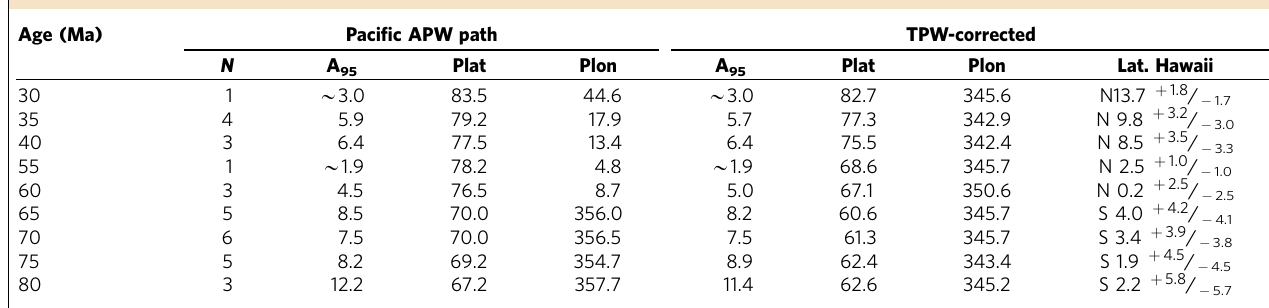
APW, apparent polar wander; TPW, true polar wander. ThePacific APWpath (Fig.8) was calculated from magneticanomaly skewness and palaeomagnetic modellingof seamounts 58–66 . We excludedall data fromthe Hawaiian-Emperor Seamounts because of possible non-dipole field contributions as discussed in the text. The APWpath is a running mean path (10Myr window lengths) based on 15 palaeomagnetic input poles (32–82Ma). N ¼ number